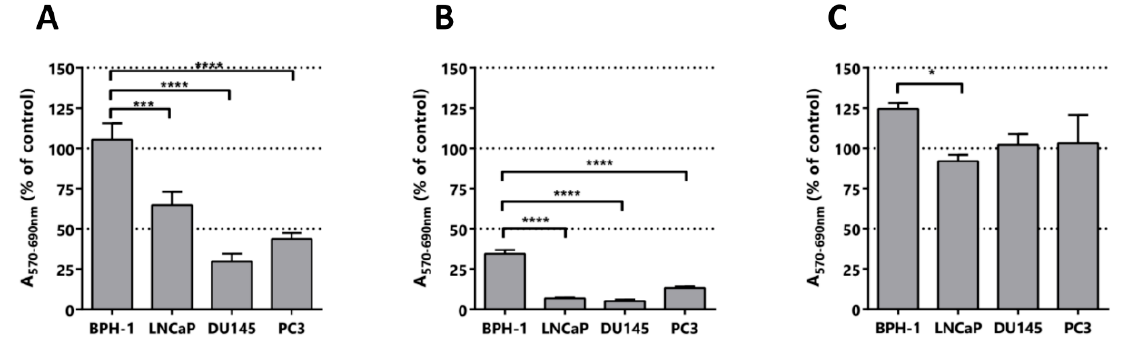
Figure 6. Selectivity assay. Cytotoxic/anti-proliferative activity after treatment of prostate cell lines with the indicated compounds. ( A ) ( E )-Ethyl 8-methylnon-6-enoate assayed at 100 μ M, ( B ) Curcumin assayed at 50 μ M and ( C ) vanillin assayed at 50 μ M. The percentages of MTT activity of the compounds was calculated relative to control cultures incubated only with DMSO. Prostate cell lines: BPH-1 derived from a benign prostatic hyperplasia (control) and LNCaP, DU145 and PC3 derived from metastatic PCa. Statistical significance is * p < 0.05; *** p < 0.001; **** p < 0.0001.